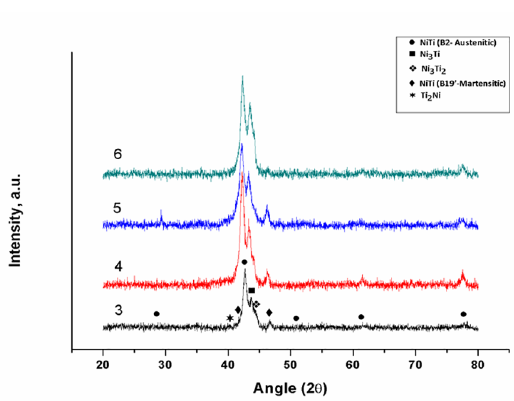
Figure 5. XRD patterns of samples sintered at 1050°C (conditions 3, 4, 5 and 6) elemental dot mapping (Fig.6.a, b). This map, which was obtained from samples prepared under condition 5 does not show any dramatic uneven distribution of elements as it is the case for samples sintered at 850°C (Fig.4.a, b). The dark areas seen in this map is common for both Ti and Ni so these regions are related to pores where no element exists (Fig.6.c). These all can be attributed to a higher sintering temperature and possible formation of eutectic liquid at 942°C, which due and crystallinity in samples 28